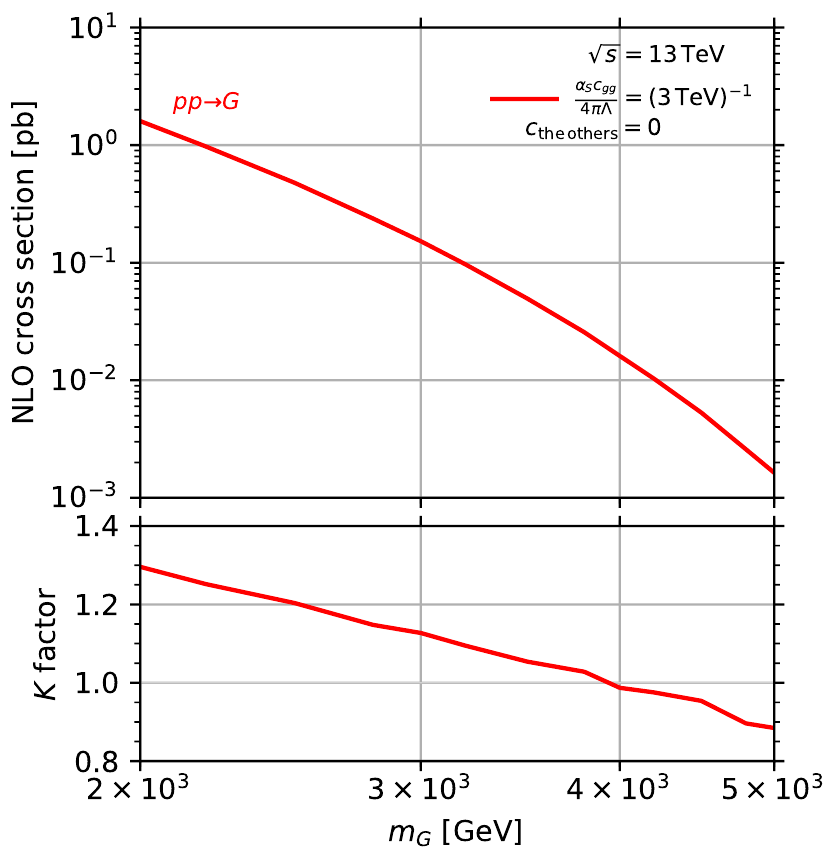
Figure 3 . Production cross sections of the KK graviton with the NLO accuracy at the 13 TeV LHC (upper panel) and K factors (lower panel) as functions of the KK graviton mass, where (cid:11) s c gg = (4 (cid:25) (cid:3)) = (3 TeV) (cid:0) 1 and the KK graviton couplings to the others including the top quark are zero.